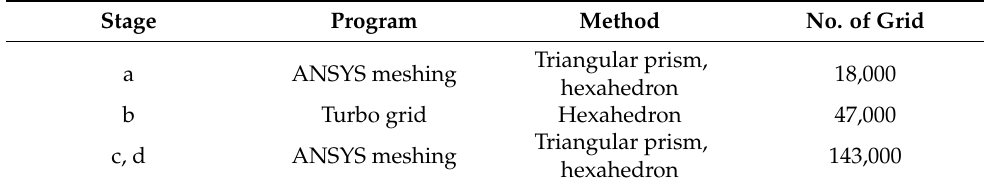
Table 4. Grid systems of the in-line oil separator in this